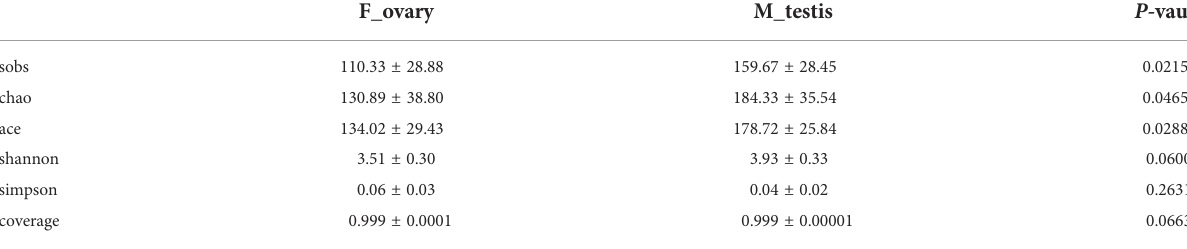
The data are expressed as the mean values ± standard deviation (SD). P-values were determined using Student ’ s t-test (*P <